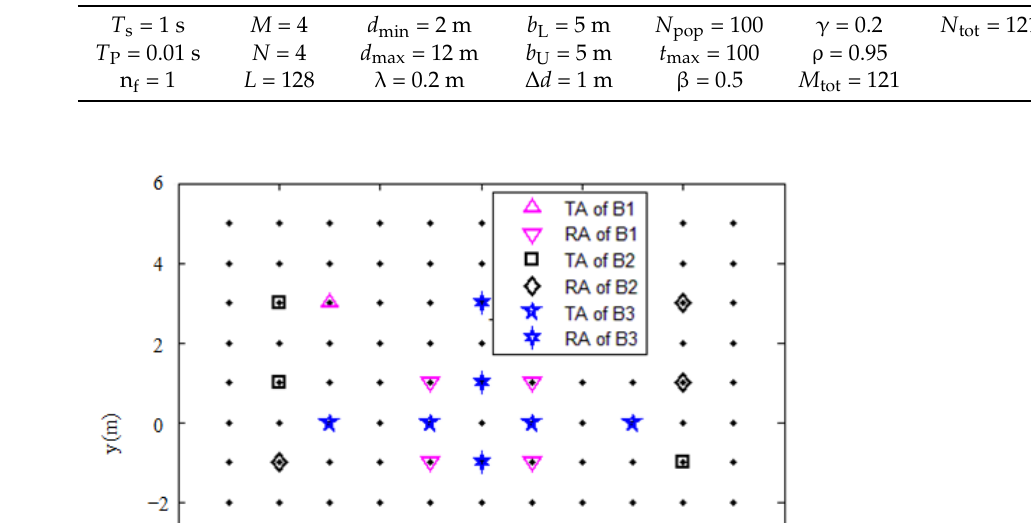
Table 2. Parameters in the scenario.